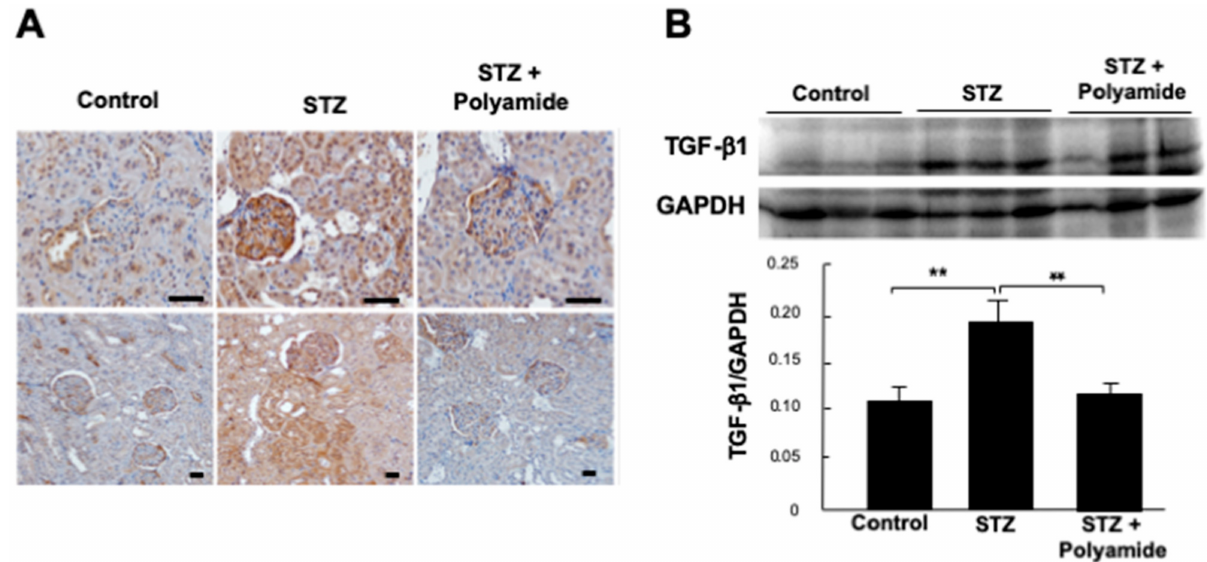
Figure 9. Effects of upstream stimulatory factor 1 (USF1) pyrrole-imidazole (PI) polyamide on the expression of transforming growth factor (TGF)- β 1 in streptozotocin (STZ)-diabetic rats. Diabetes mellitus was induced in rats by single intraperitoneal injection of STZ. STZ-induced diabetic rats were intraperitoneally injected with 1 mL of 0.1% acetic acid as control rats. Then, 1 mg/kg body weight of USF1 PI polyamide dissolved in 1 mL of 0.1% acetic acid was intraperitonially injected twice a week for 4 months. ( A ) Immunohistological staining of TGF- β 1 in control and STZ-diabetic rats without or with USF1 PI polyamide-3. ( B ) Expression of TGF- β 1 in the renal cortex evaluated by Western blot analysis. Data are the mean ± SEM ( n = 3). ** p < 0.01 between indicated columns. The scale bar indicates 25 µ